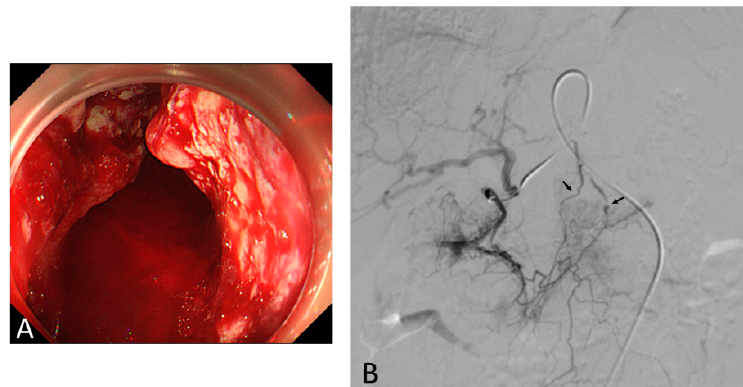
Figure 4. A large ulcerative tumor with spurting hemorrhage from the cardia to the whole body was confirmed endoscopically ( A ); however, endoscopic hemostasis failed due to massive bleeding. A selective right gastric artery angiogram revealed two contrast extravasations (arrows), one of which accompanied pseudoaneurysm ( B ). However, transcatheter angiographic embolization was not indicated because of the failure of super-selective catheterization.